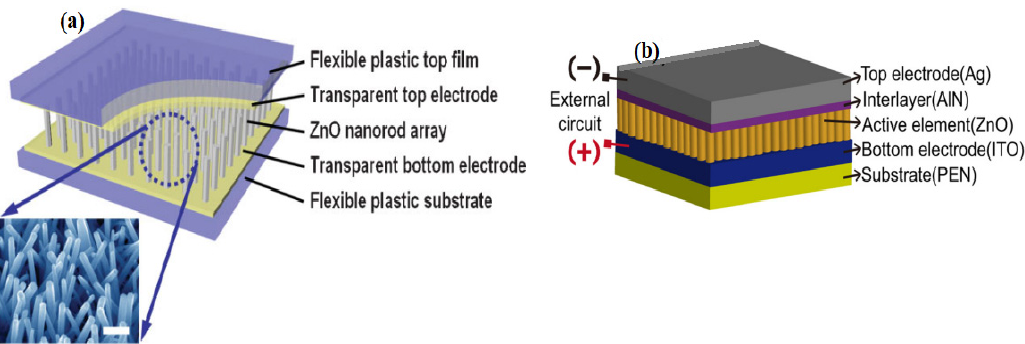
Figure 13. ( a ) Flexible transparent charge-generating piezoelectric nanodevices with ZnO nanorods. Inset; FESEM image of ZnO nanorod arrays sandwiched between the flexible plastic substrates. ( b ) Photographic image of the fully flexible charge-generating ZnO nanorod device with stacked ZnO/AlN-film substrates. Reprinted with permission from ref. [157]. Copyright 2009 John Wiley and Sons. Reprinted with permission from ref. [158]. Copyright 2015 AIP Publishing.